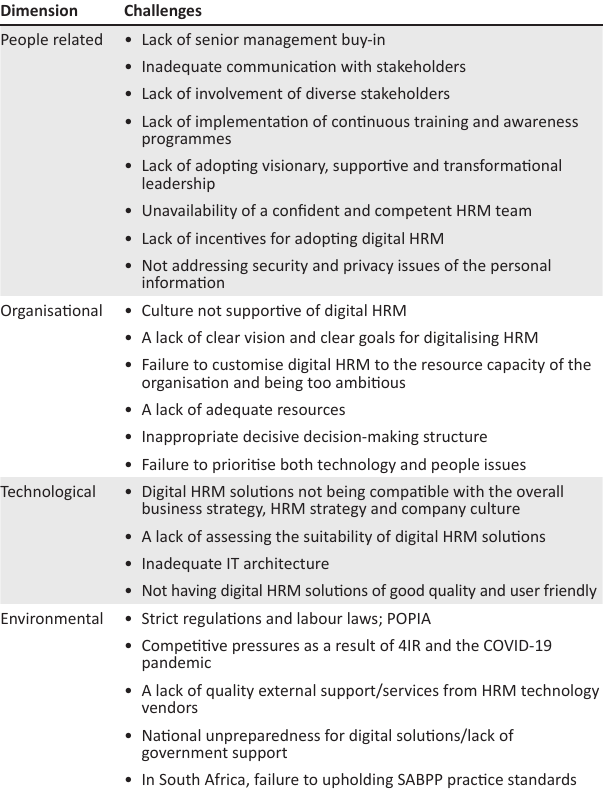
TABLE 1: Summary of challenges in the successful adoption of digital human resource management.